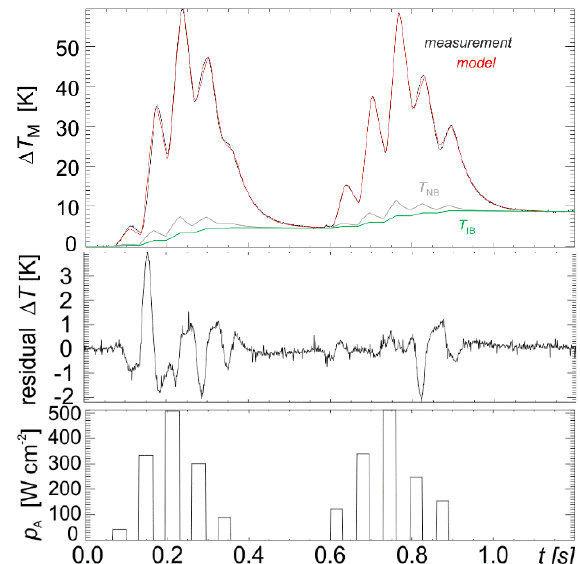
Fig. 10. Measured signal response to pulses of mm-wave power without plasma, compared with the modelling. Pulse amplitudes (bottom row) are the fit results. The main part of the residual (middle row) can be understood from the fact, that the model intensity amplitude is assumed to be constant within one pulse. In reality, during the fast launcher sweep for example in the second pulse (at approx. 0.15 sec) the absorbed mm-wave intensity increases during the measurement. The model fits an average value and, therefore, the residual, which is model minus measurement, is positive during the first part of the pulse. The observer should keep in mind, that there is a time lag between the mm-wave power and the measurement. The data was recorded as AUG experiment #39744.